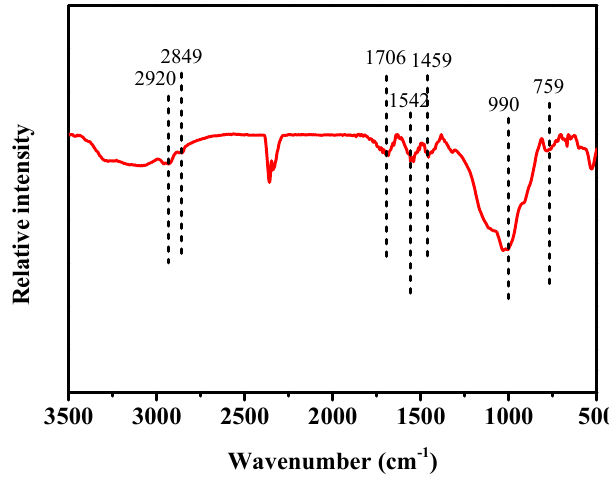
Figure 8. Fourier-transform infrared spectroscopy imaging of the binding in sample mortar.